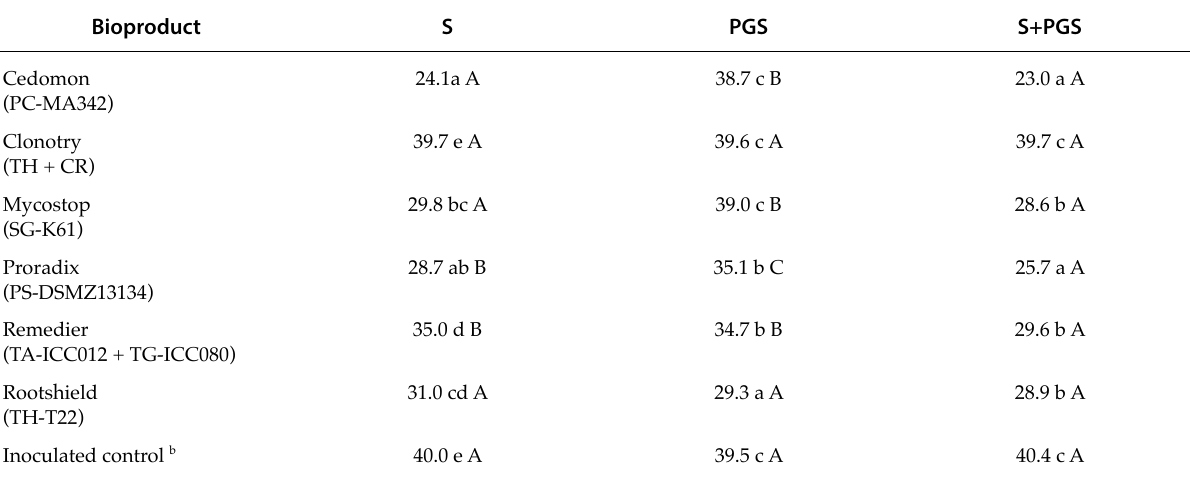
Table 3. Effect of bioproducts applied to seed (S), to plant growth substrate (PGS) and to both (S+PGS) on the disease sever